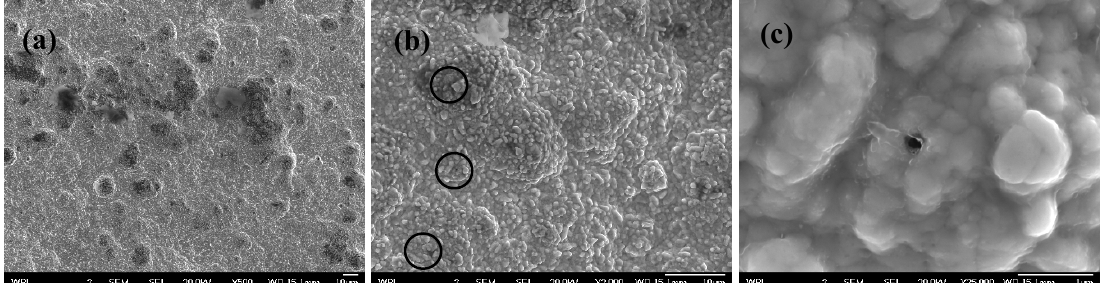
Figure 12. SEM image of the Pd-Au membrane befor ( a , b ) and after the permeation tests ( c , d ).